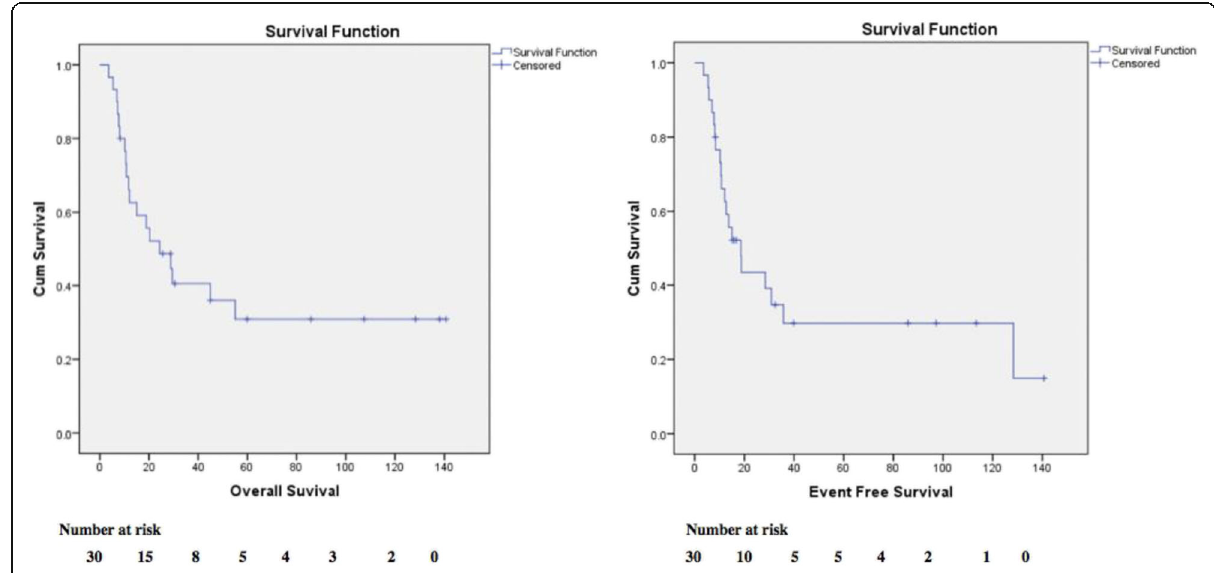
Fig. 1 Survival outcome for study group patients